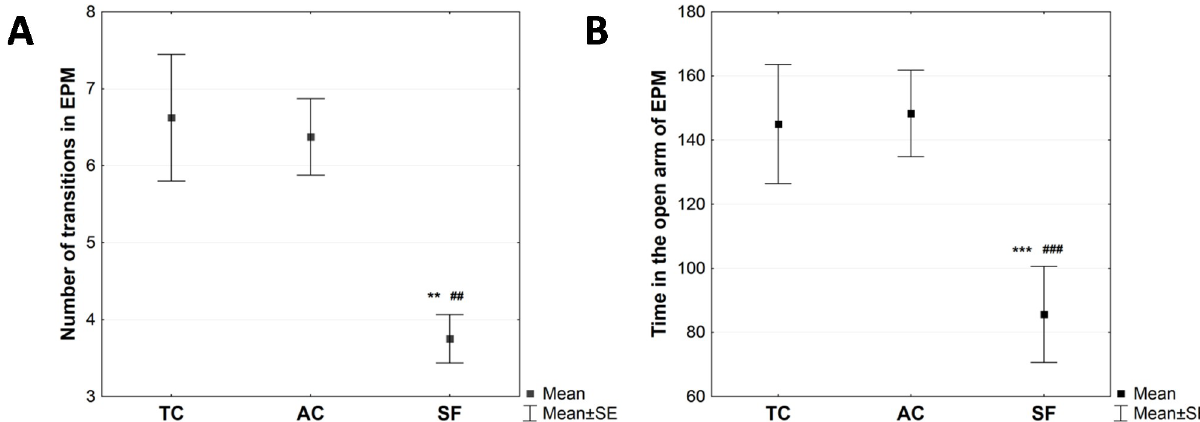
Fig 3. The number of transitions between the opened and closed arm (A) and the time spent in the open arm (B) in elevated plus maze test (EPM) observed in animals from treadmill control (TC), activity control (AC) and sleep fragmentation (SF) group upon sleep fragmentation method. Values are mean ± SEM. The statistical difference between the groups was estimated by using One-Way ANOVA with Fisher’s LSD post hoc test ( �� p < 0.01, ��� p = 0.001 vs. TC, ## p < 0.01, ### p = 0.001 vs. AC). For further details see the caption to Fig 1.